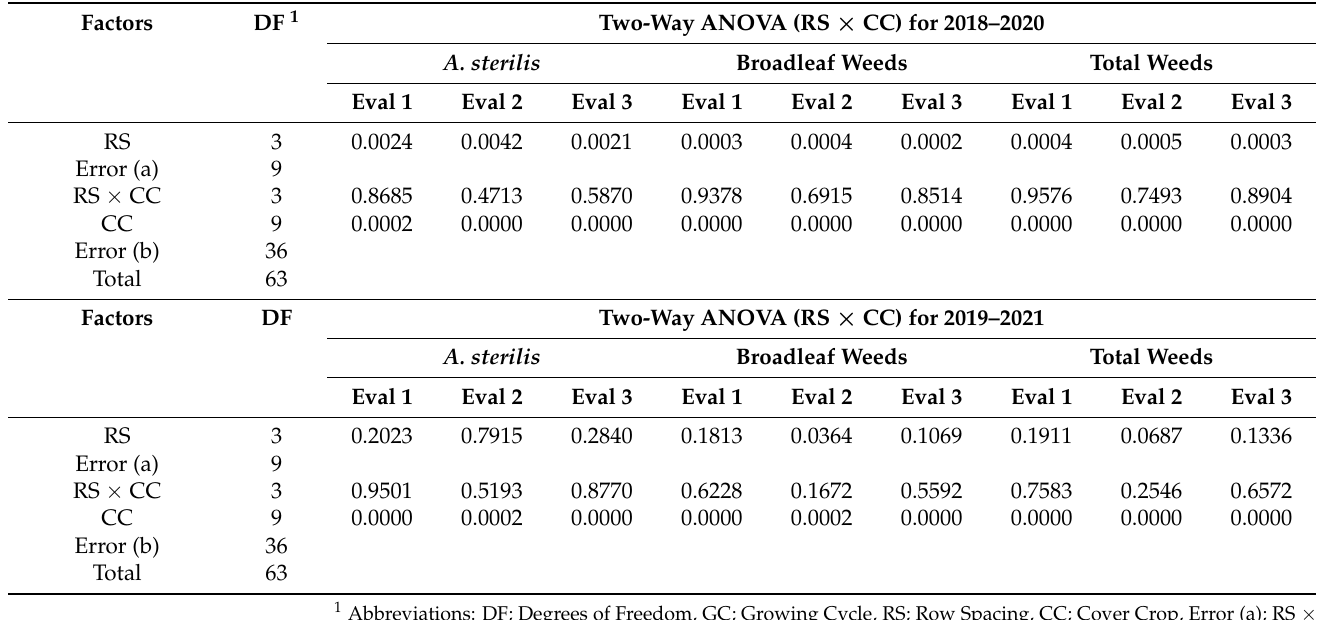
Table 2. The effects of sulla row spacing and cover crops on A. sterilis biomass, broadleaved weed biomass, and total weed biomass in the first year of sulla growth in the 2018–2020 and 2019–2021 growing cycles. Data were analyzed separately for each growing cycle.